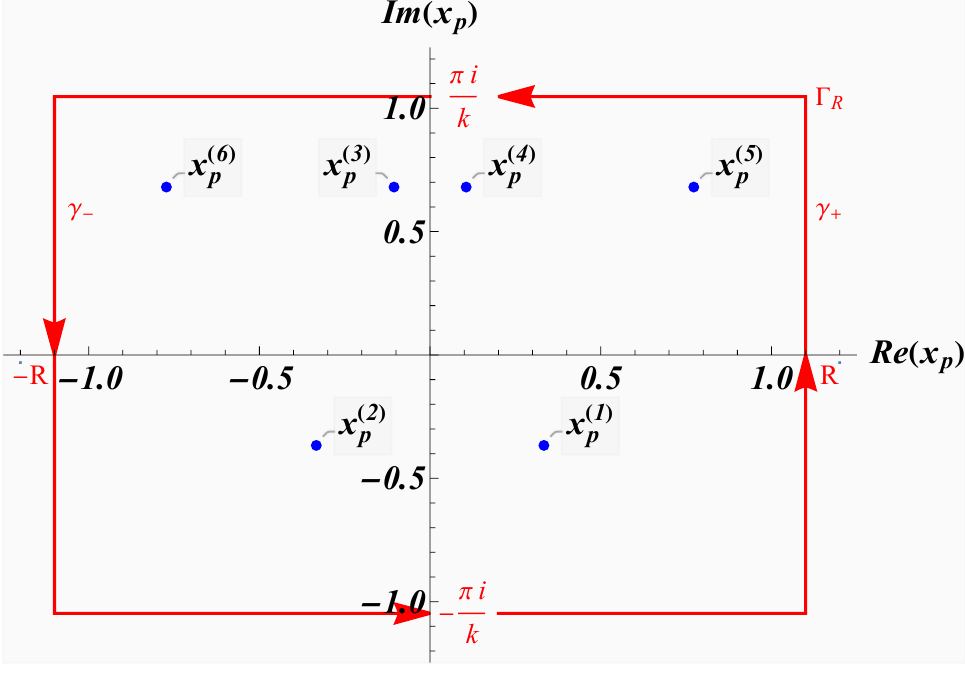
Figure 5 . Integration contour Γ R and poles of G ( x ) for u = 6 / 5 , k = 3 , β = 9 / 10